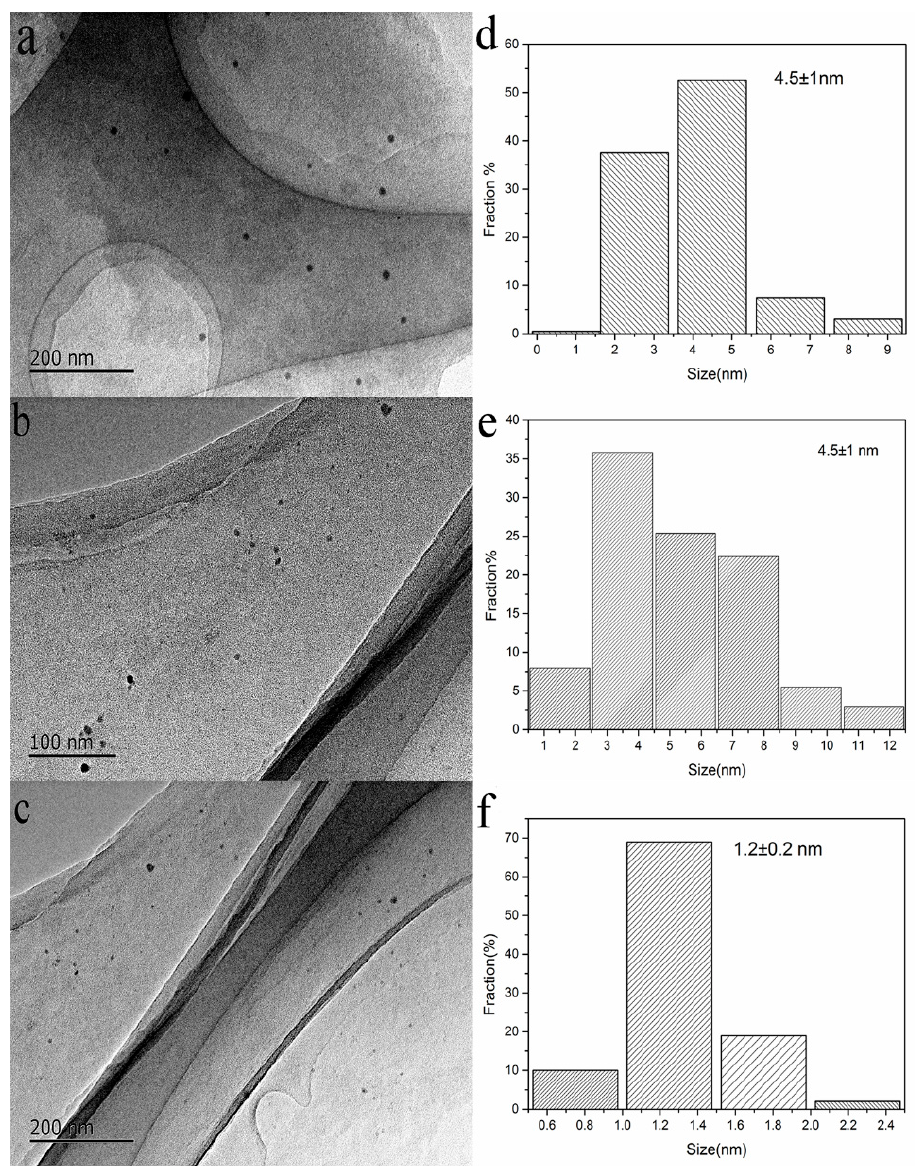
Figure 1. Typical transmission electron microscopy (TEM) images of synthesized carbon